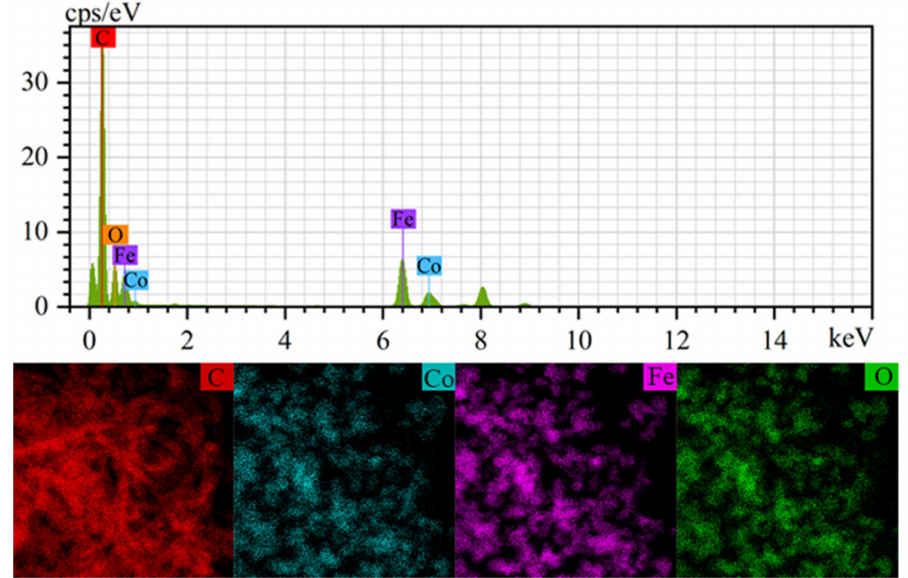
Figure 3. The elemental energy spectrum of CoFe 2 O 4